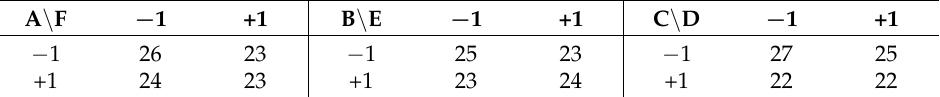
Table 11. Analysis of the interactions AF+BE+CD versus Vv Cementite (%) in Region II. A \ A\F